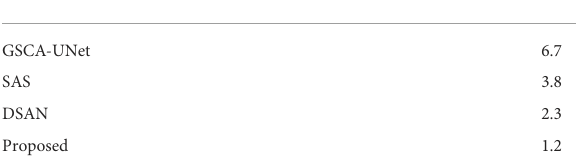
TABLE 2 The average detection results on the SBU dataset. Method